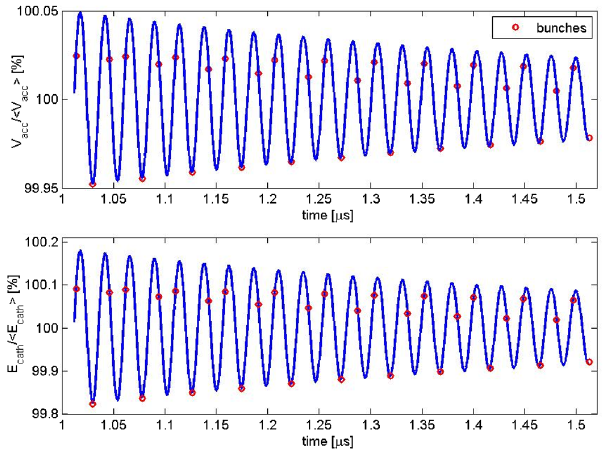
FIG. 28. Peak voltage and cathode E field (for t > t normalized to the average one along the bunch train. FIG. 29. Sketch of the rf